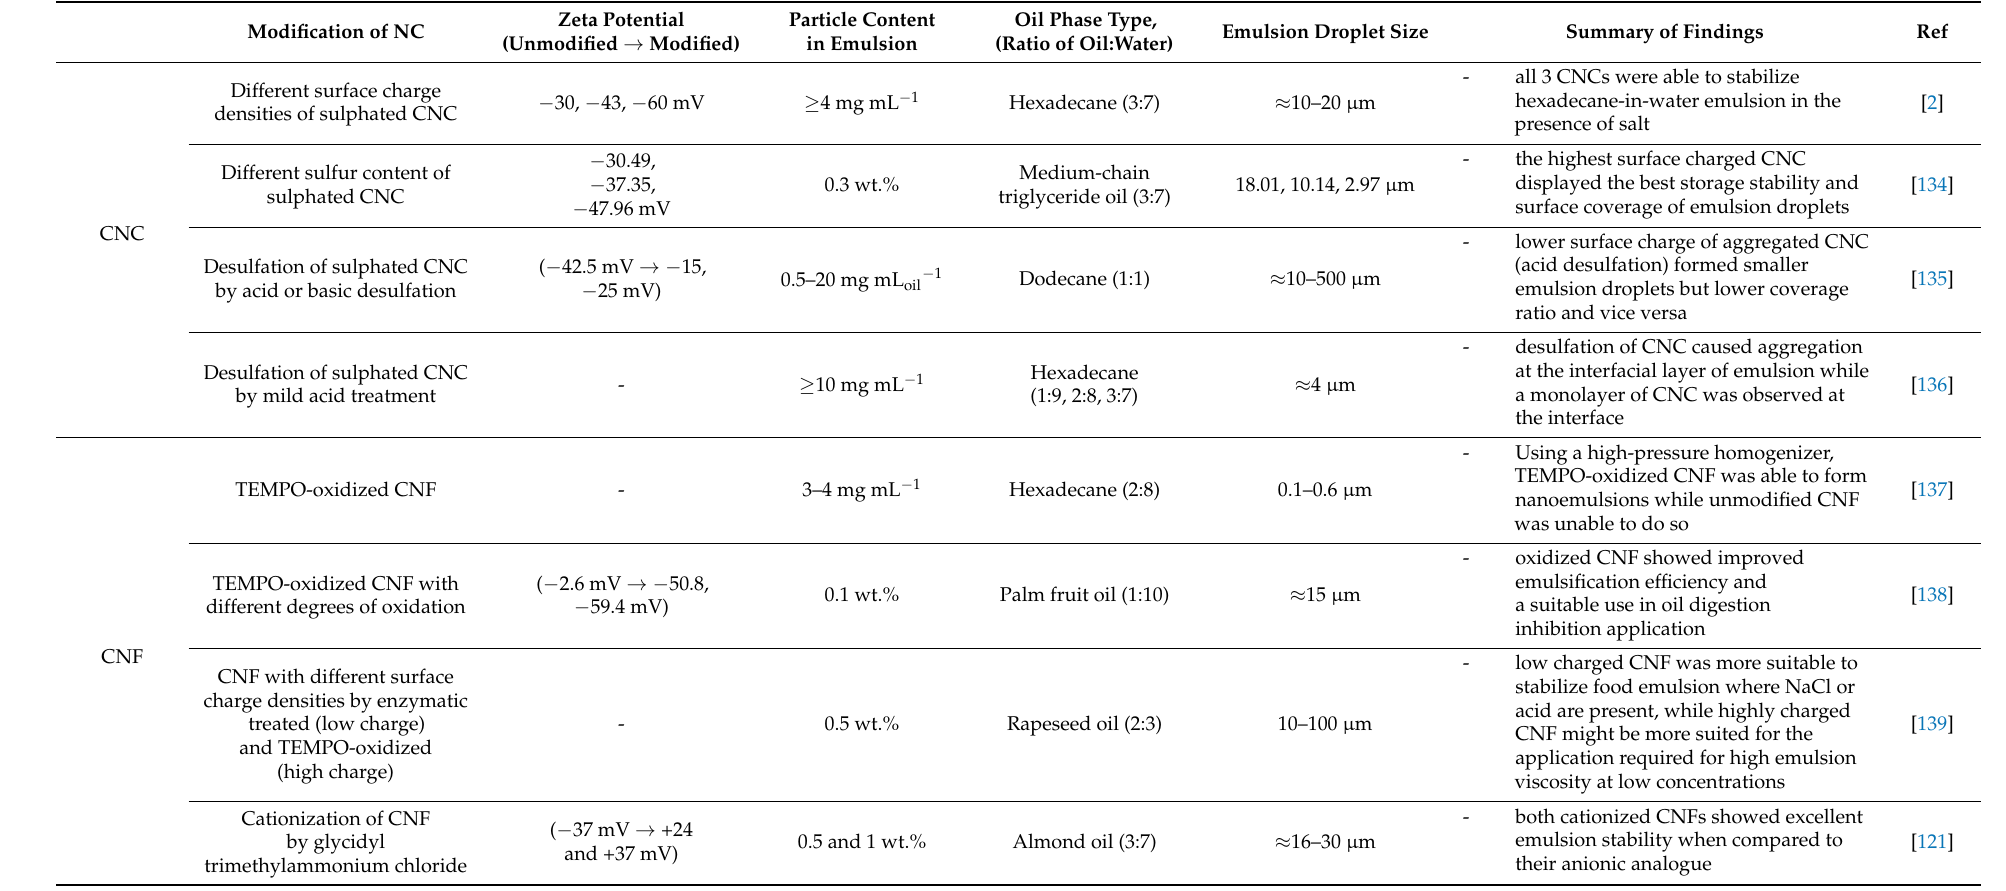
Table 5. Summary of scientific studies on the different surface charges of CNC and CNF derivatives in their use as Pickering emulsifiers. Zeta Potential Particle Content Oil Phase Type, Emulsion Droplet Size Summary of Findings Modification of NC (Unmodified → Modified) in Emulsion (Ratio of Oil:Water)